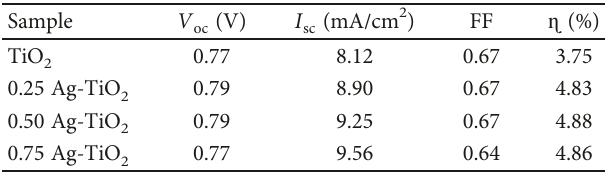
Figure 5: I - V curves of DSCs. Table 3: Performance parameters of DSCs based on photoanodes nano-Ag-TiO and TiO -P25. 2 2